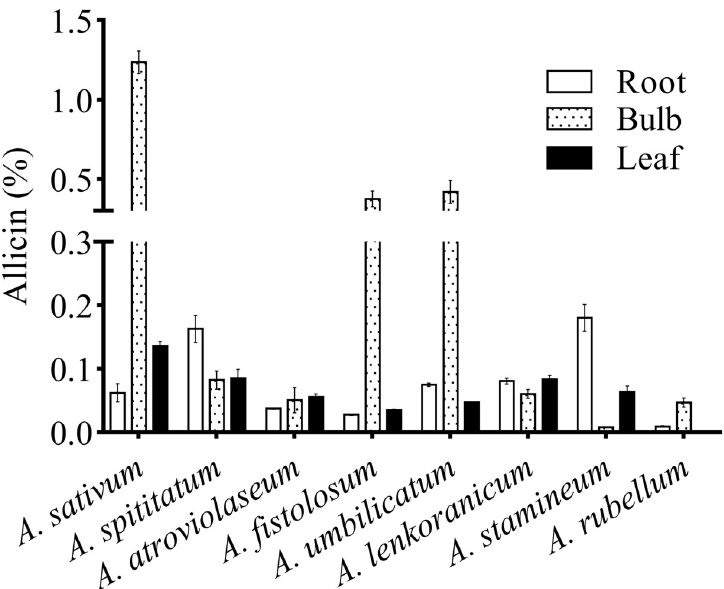
https://doi.org/10.1371/journal.pone.0228747.g004